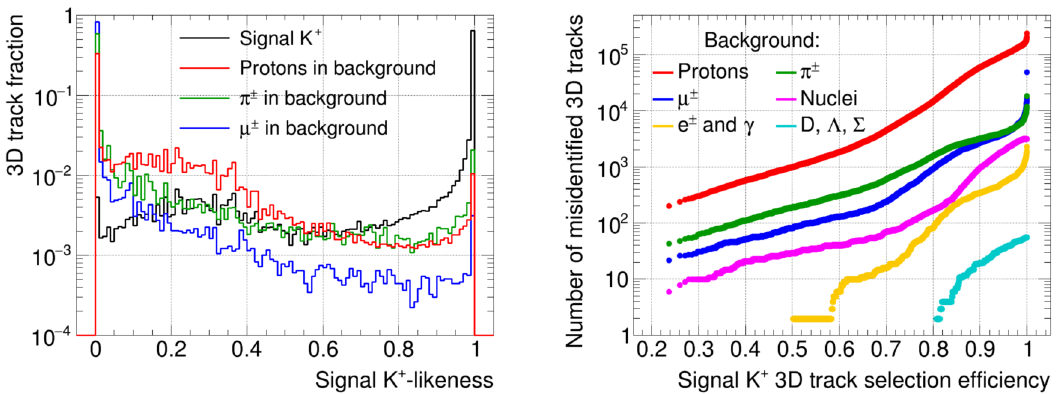
Figure 7 . Left: fraction of 3D tracks as a function of neural network signal K + -likeness for K + in the signal sample and protons, pions and muons in the background sample. The inflection point at a signal K + -likeness of 0.83 for protons, pions and muons in the background sample motivates the corresponding neural network cut in the final event selection. Right: number of 3D tracks in the background sample misidentified as signal K + as a function of signal K + track selection efficiency after event and particle preselection, using the signal K + -likeness obtained from the neural network. Both figures show the reference signal and 10 megaton · years background